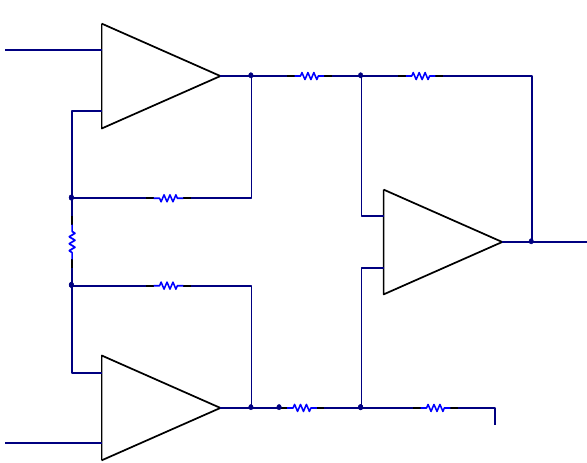
Figure 4. Instrumentation amplifier